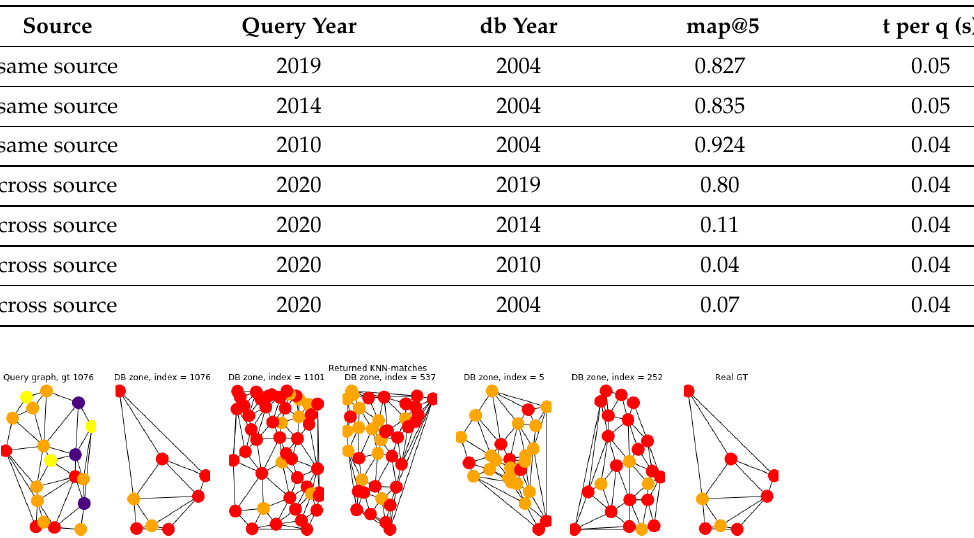
Table 3. map@5 Faiss similarity search results, same source database with clutter graphs.